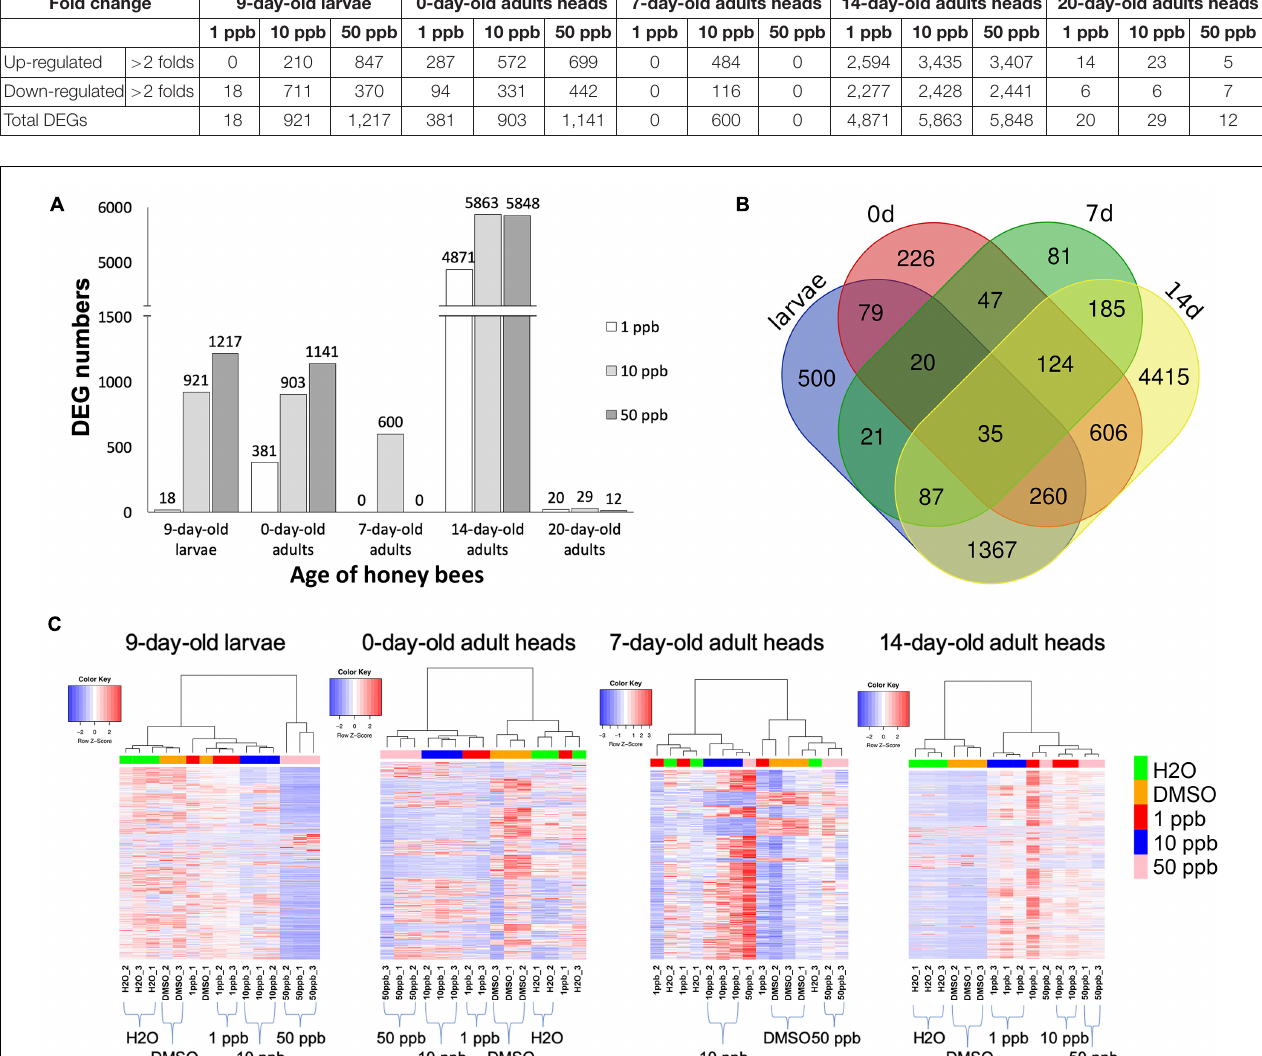
FIGURE 1 | Numbers of differentially expressed genes at various developmental stages of worker bees. (A) Numbers of differentially expressed genes (DEGs) in 9-day-old larvae, as well as in 0-, 7-, 14-, and 20-day-old adults of honey bees exposed to 1-, 10-, or 50-ppb imidacloprid treatment for 4 days during the larval stage. Original numbers of DEGs are shown on top of each column. X-axis: the developmental stages of honey bees; Y-axis: the number of differentially expressed genes. (B) Venn diagram of shared DEGs of 9-day-old larvae, 0-, 7-, and 14-day-old adults among all concentrations of imidacloprid. The numbers of shared DEGs are shown in the overlapped region. Larvae: 9-day-old larvae; 0d: 0-day-old adults; 7d: 7-day-old adults; 14d: 14-day-old adults. (C) Cluster analysis of DEG expression patterns of 9-day-old honey bee larvae, as well as 0-, 7-, and 14-day-old adults. Read counts were used for cluster analysis. Complete normalization was applied, and the clustering was performed based on Pearson correlation coefficients. The expression trend of each replicate is shown. Controls (H 2 O and DMSO) and different concentrations of imidacloprid treatments (1, 10, and 50 ppb) are labeled in the bottom panel and marked with different colors in the panel of the dendrogram. Red: expression levels higher than average; blue: expression levels lower than average; white: expression levels close to